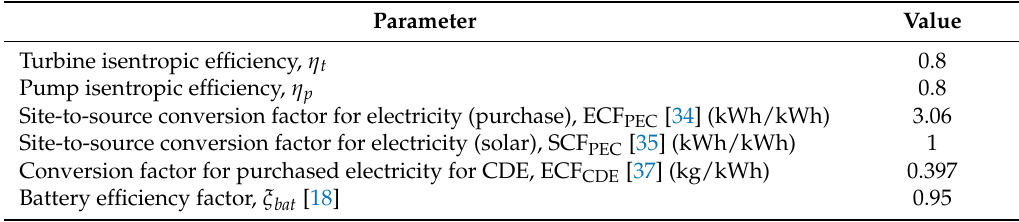
Table 2. Parameter values used in the model.